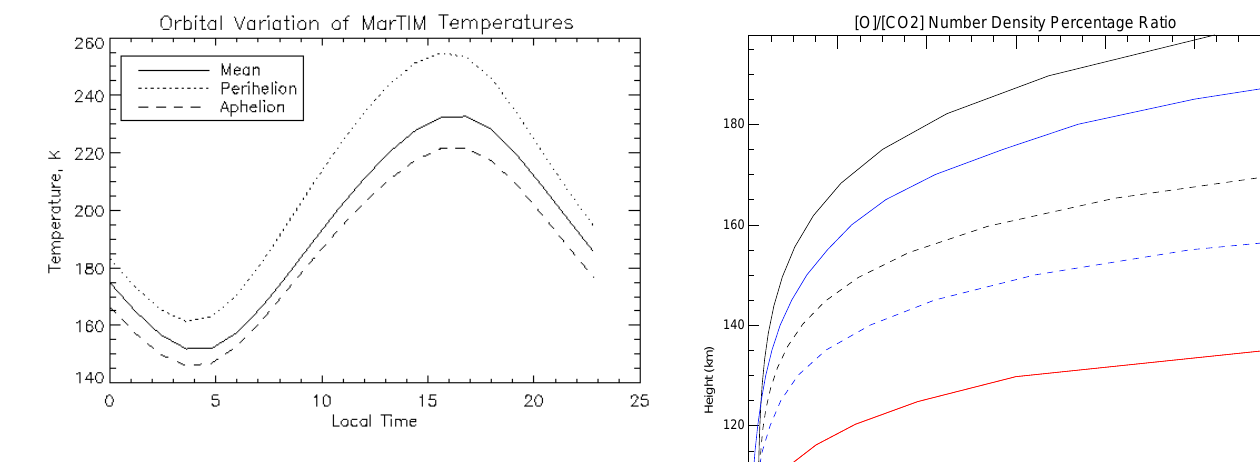
Fig. 2. Thermospheric (pressure=2.7 × 10 − 7 Pa) temperature varia- tions, from MarTIM, for solar minimum conditions, for perihelion, aphelion and mean orbital positions, along the equator over a day.